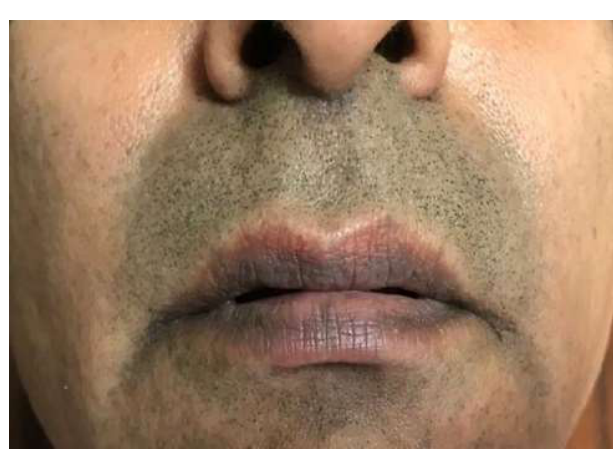
Figure 2 . Residual Hyperpigmentation 10-Weeks After Cessation of the Offending